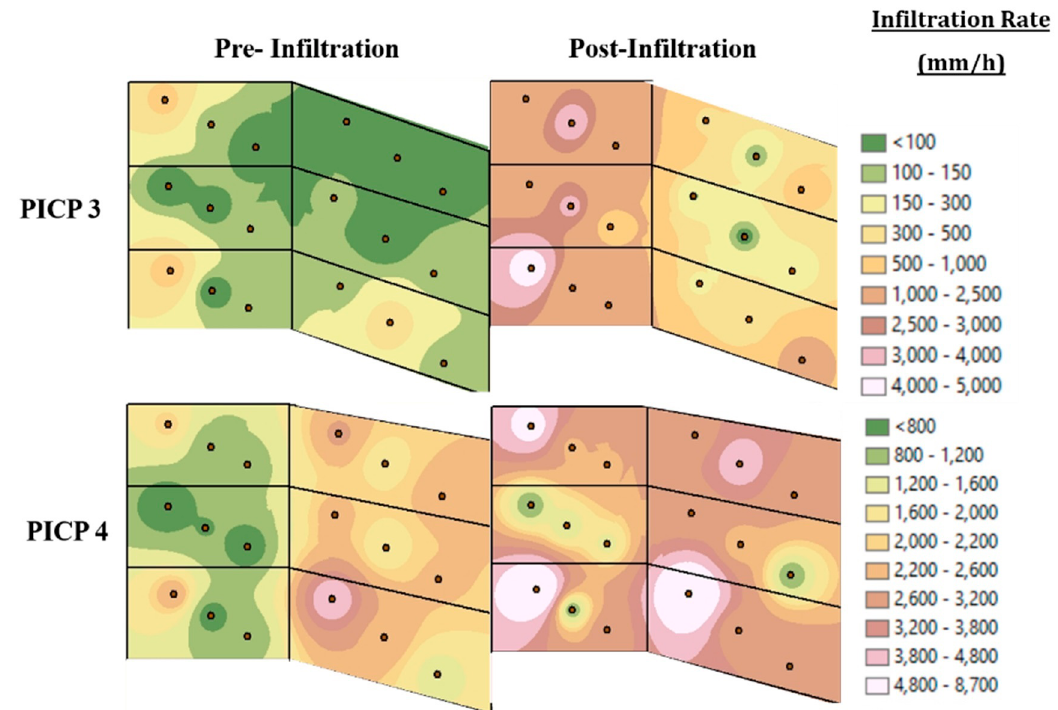
Figure 10. Spatial Variability of Infiltration Capacity at Field Site 2.